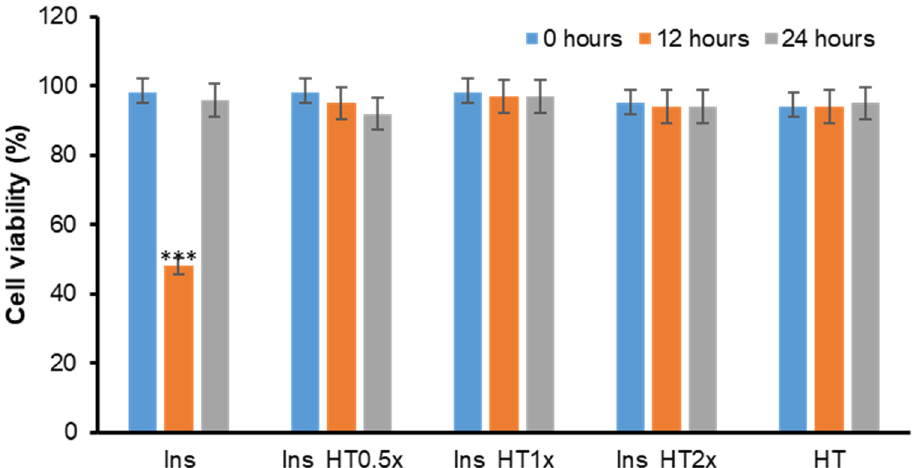
Figure 4. E ff ect of HT on insulin amyloid toxicity. Cytotoxicity of insulin amyloid species formed in the absence and in the presence of HT. SH-SY5Y cells were exposed for 24 h to insulin incubated for 0, 12 and 48 h in aggregating conditions in the absence and in the presence of HT (0.5, 1, and 2x) and cell viability was evaluated by MTT assay. Data are expressed as average percentage of MTT reduction ± SD relative to control cells from triplicate wells from 5 separate experiments ( p < 0.01). ***: p < 0.001. HT represents cells exposed to HT at the higher working concentration. Other experimental details are described in the Methods section.